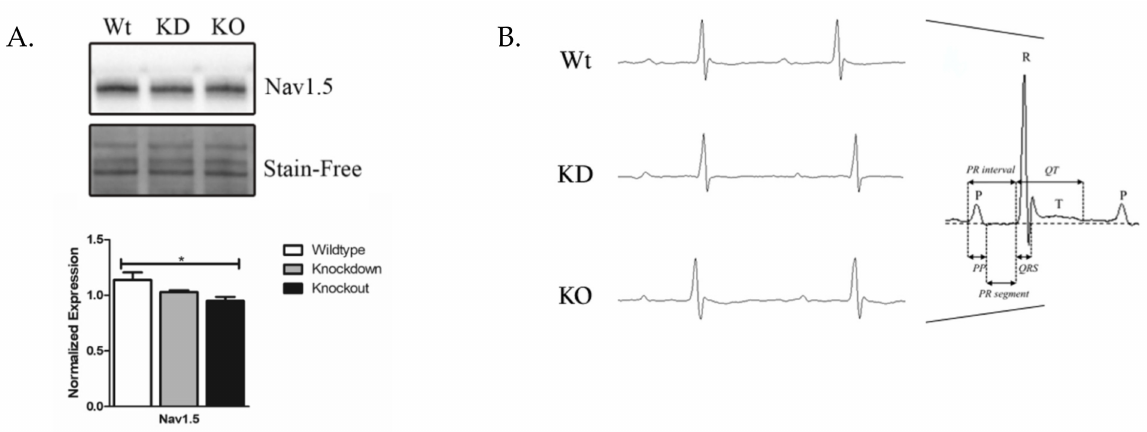
Figure 10. Nav1.5 expression and electrocardiography in SLMAP3-deficient hearts. ( A ) Western blot with anti-Nav1.5 in Wt, KD and KO adult mouse hearts lysates. Bar graphs represent quantification of Nav1.5 expression normalized to total protein loading visualized by Stain-Free. ( B ) Representative electrograms of lead ii acquired by surface 6-lead ECG in Wt, KD and KO adult mice. n = 3. * ρ < 0.05, ρ value was calculated using ANOVA statistical analysis. Table 2. Electrocardiography of SLMAP3-deficient hearts. Parameters of electrocardiography in Wt, KD and KO adult mice (detailed in materials and methods). n = 3. ρ value was calculated using ANOVA statistical analysis.